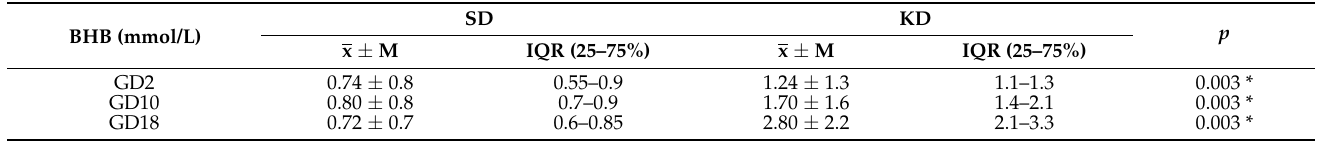
Table 2. Maternal blood β -hydroxybutyrate (BHB) levels.